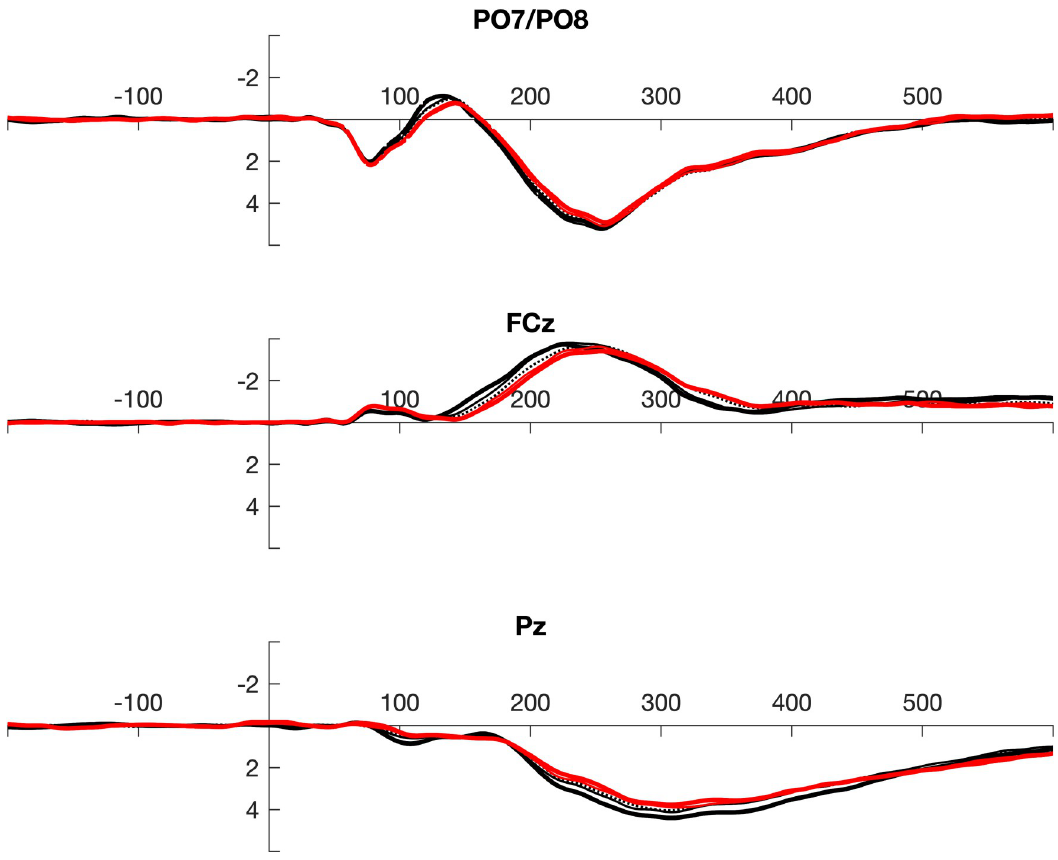
Fig 5. Grand averages for the 5 time on task segments (1: Black bold, 2: Black thin, 3: Black dotted, 4: Red thin, 5: Red bold). For N1, N2 and P2 components, latencies increase clearly with time on task (ToT). For the P1 only a modulation in the offset is visible that might be already driven by the following N1 effect. P3 changes before most in amplitude and morphology.